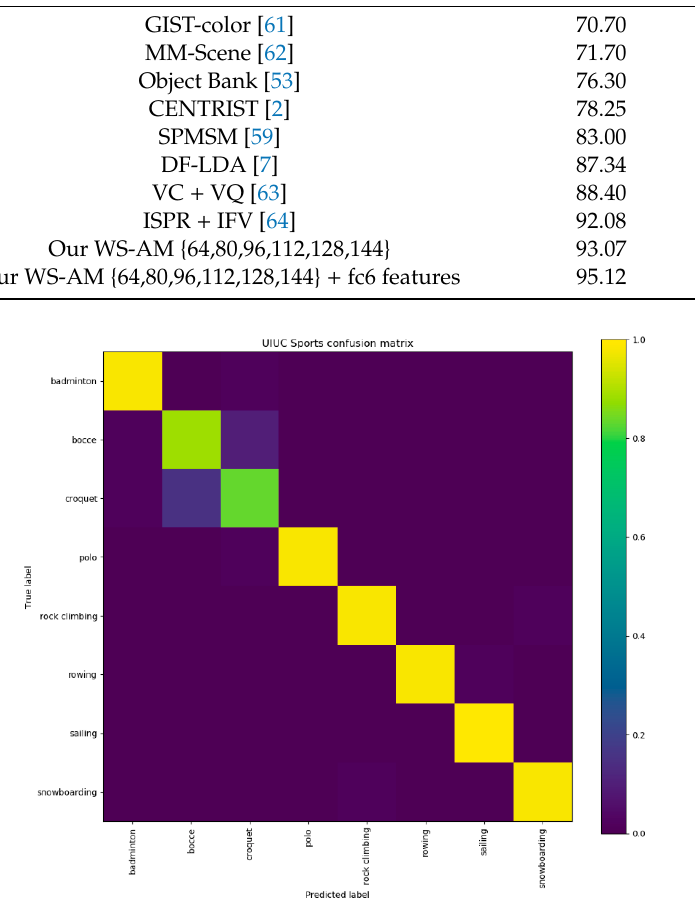
Figure 9. Confusion matrix of UIUC Sports dataset.